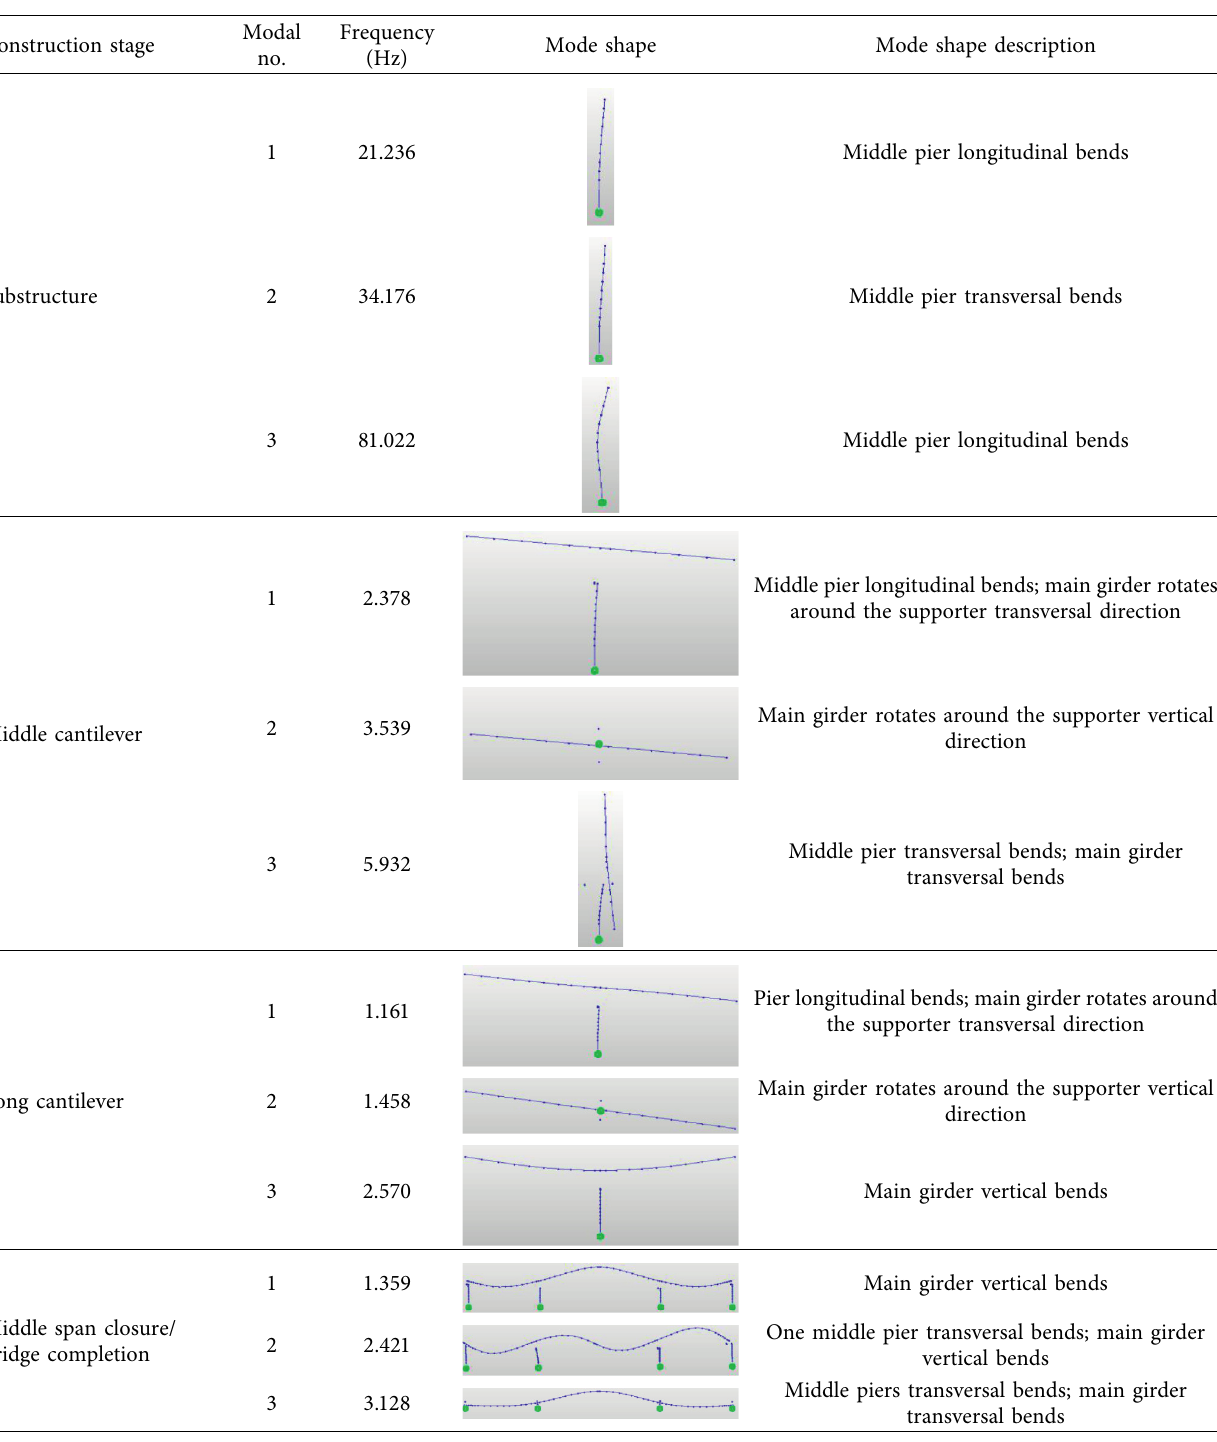
Table 2: The modal information of the